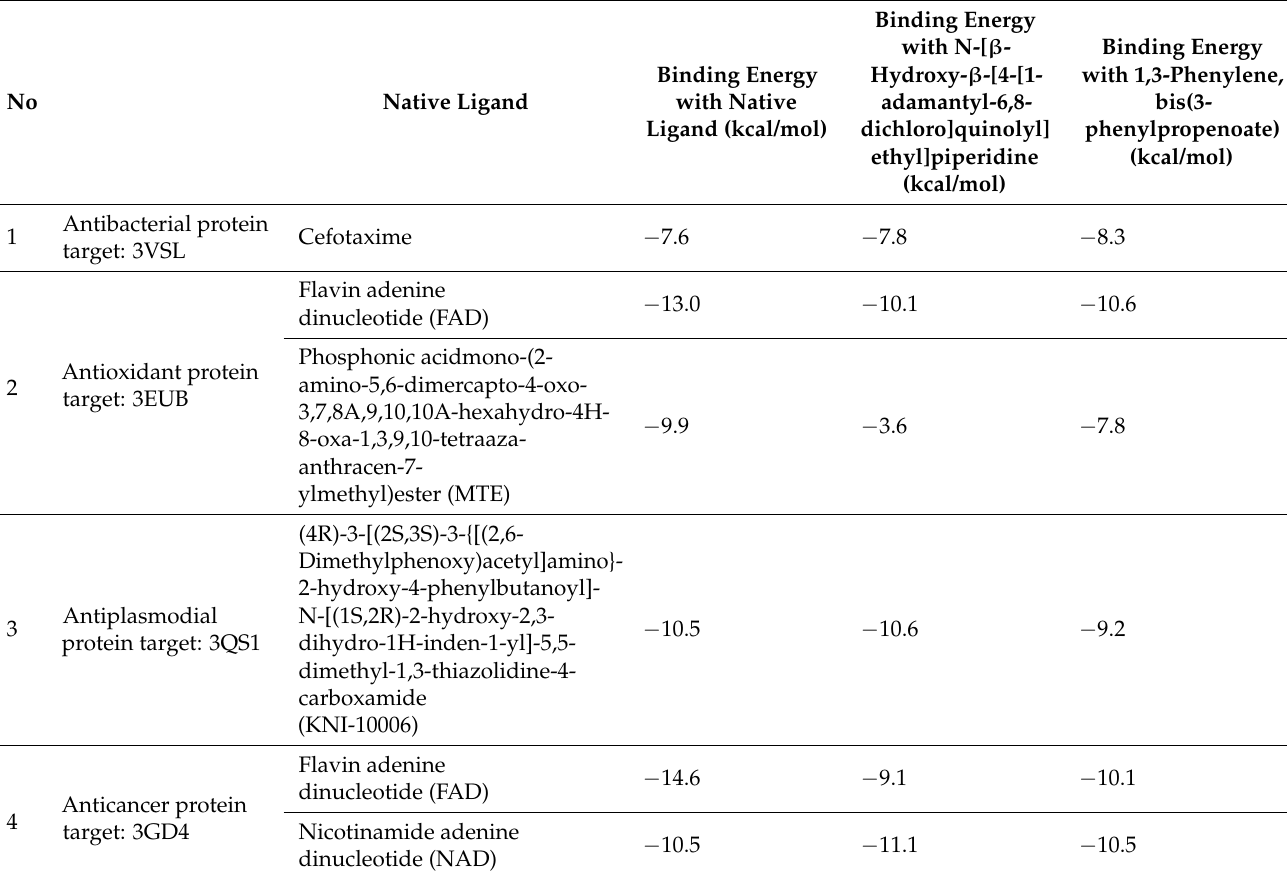
Table 3. Binding affinity of identified compounds against selected target